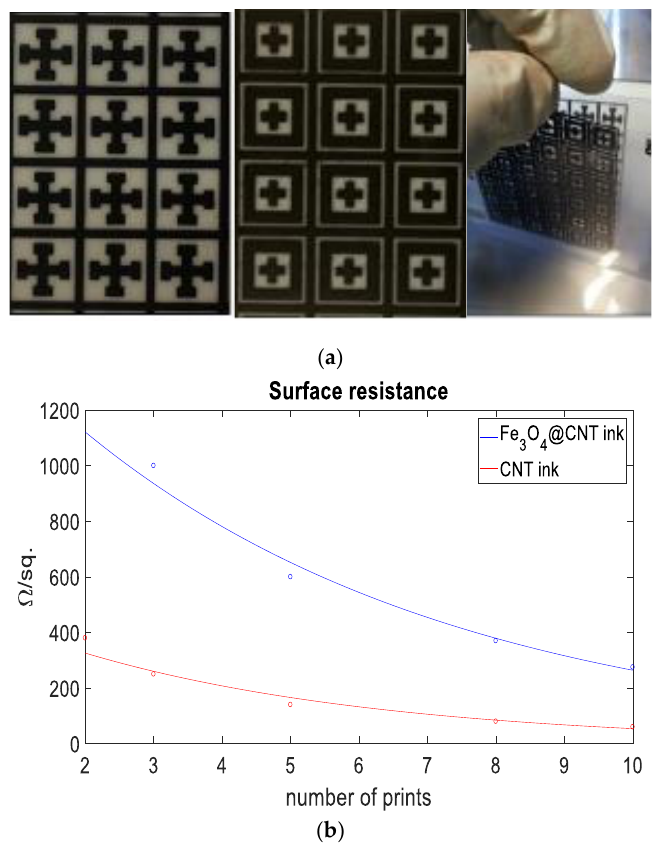
Figure 19. ( a ) ink-printed patterns (adapted from [26]: left Jerusalem cross, center square ring enclosing a dipole cross, right perspective view) ( b ) measured surface resistance for MWCNTs only-ink and for magnetite@MWCNTs-ink as function of number of prints.